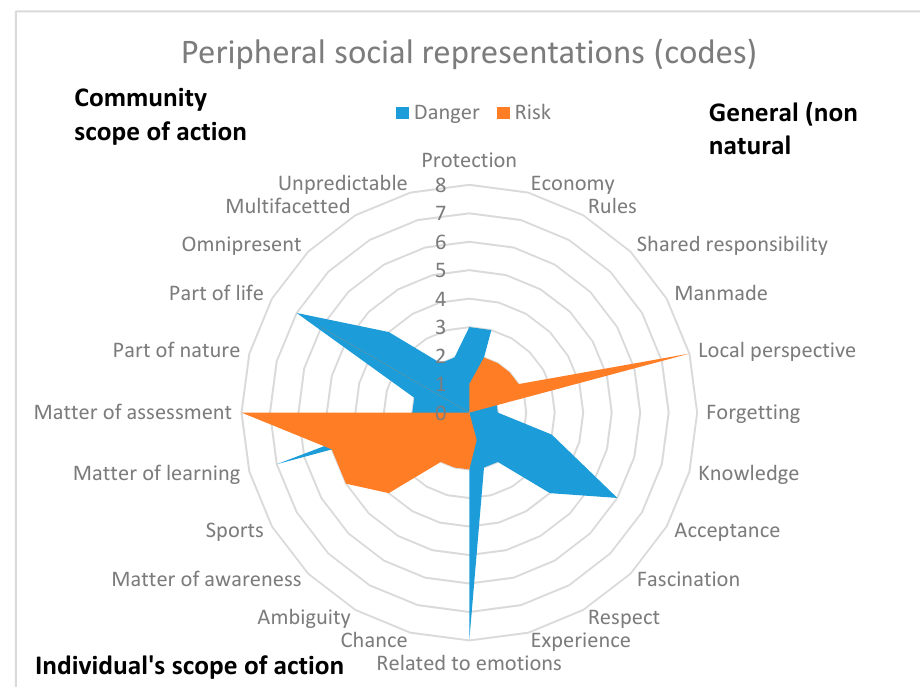
Figure 9. Peripheral social representations of risk and danger ( ≤ 8 namings, that is, the number of namings).